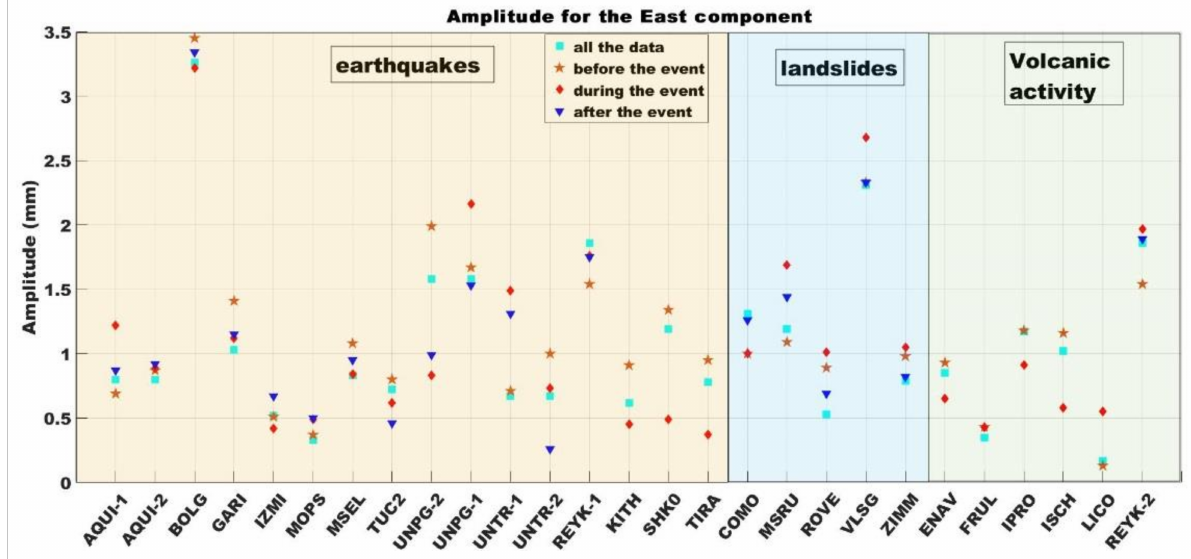
Figure 4. Seasonal signals for the East component in the presence of geophysical events using the four above-mentioned computational